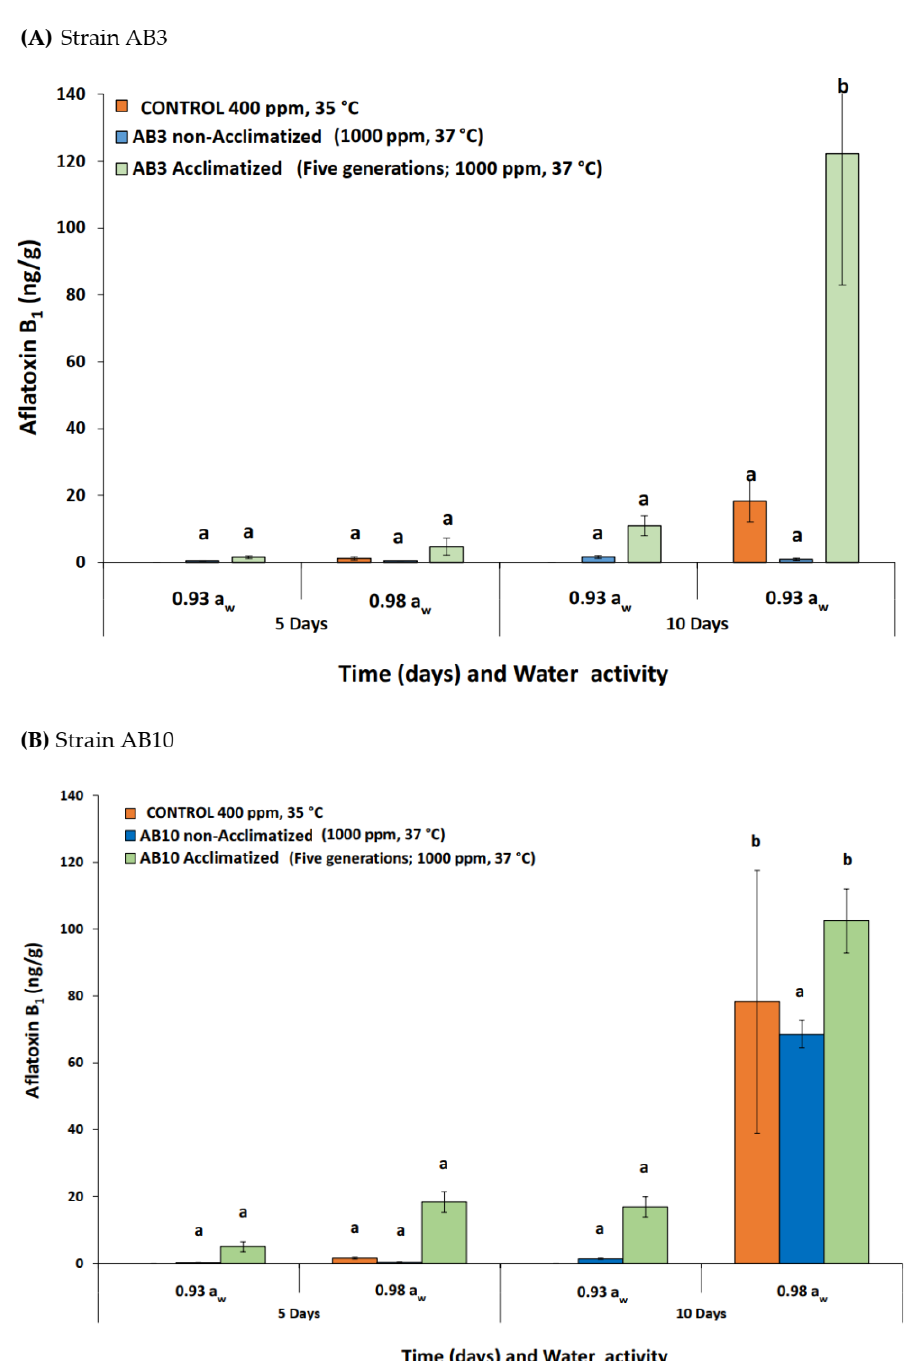
Figure 2. ( A ) Strain AB3 and ( B ) strain AB10: Aflatoxin B 1 production of non-acclimatized and acclimatized (for five generations) of Aspergillus flavus strains on colonised layers of raw pistachio nuts incubated at 35 ◦ C + 400 ppm CO 2 and 37 ◦ C + 1000 ppm CO 2 . Data are means of triplicates. Different letters indicate significant differences between treatments ( p < 0.05) by Fisher’s least significant difference